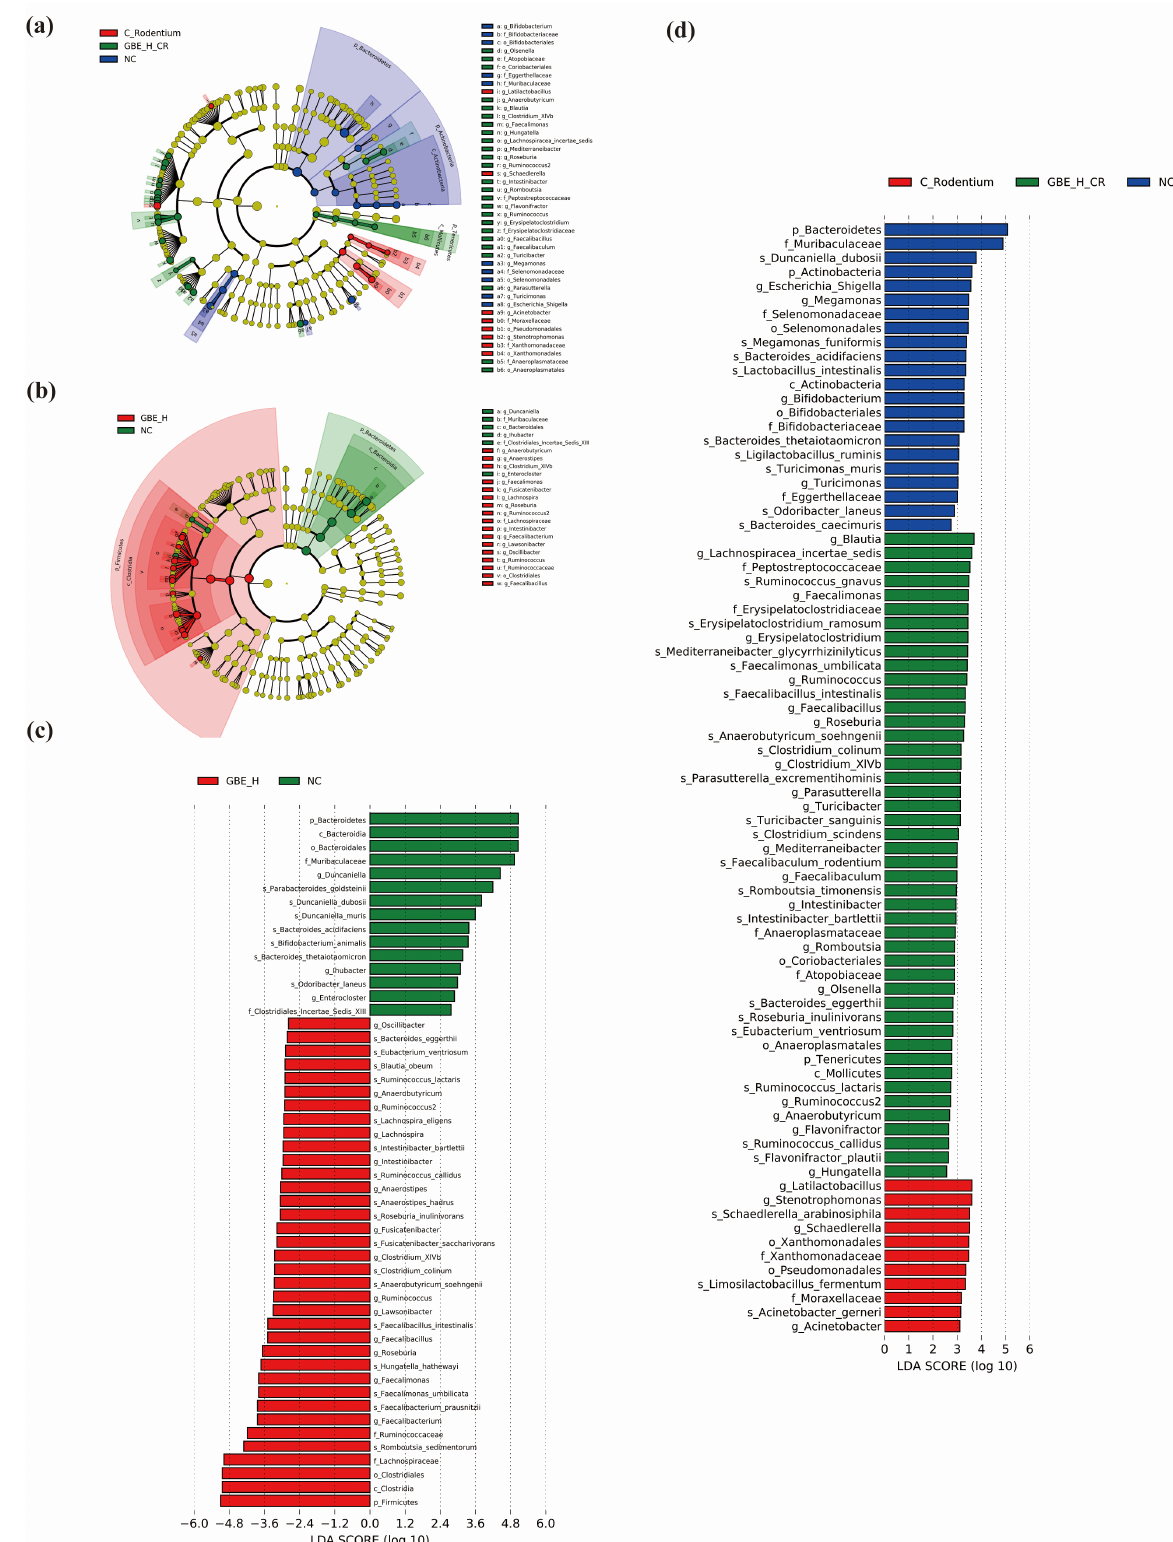
Figure 7. Role of GBE supplementation in key microbial phylotypes. Taxonomic cladogram ( a ) and histogram of LDA scores ( d ) obtained by LEfSe analysis among the NC, C. Rodentium, and GBE_H_CR groups. Taxonomic cladogram ( b ) and histogram of LDA scores ( c ) obtained by LEfSe analysis between the NC and GBE_H